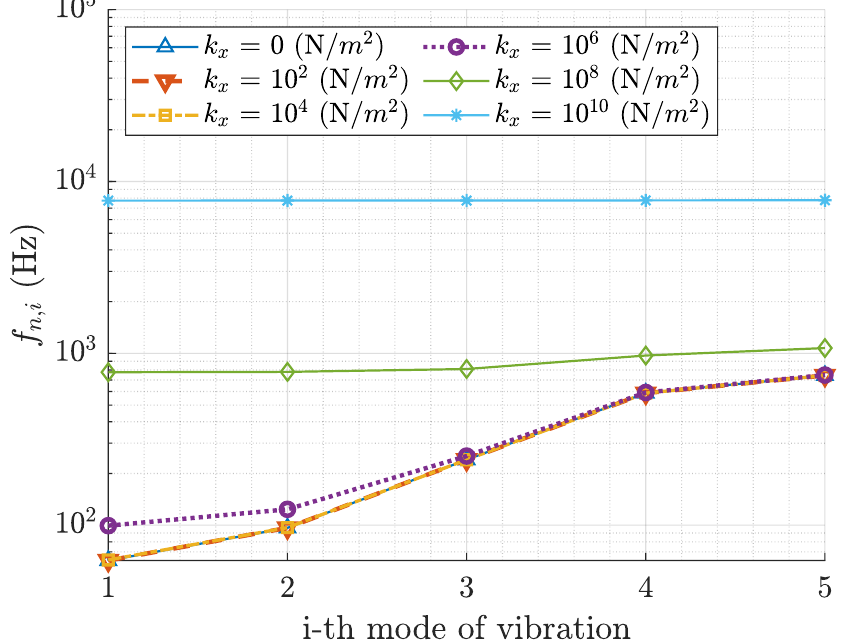
Figure 8. Natural frequencies of the first five modes of vibration of the retracted slat as a function of the distributed stiffness k x .